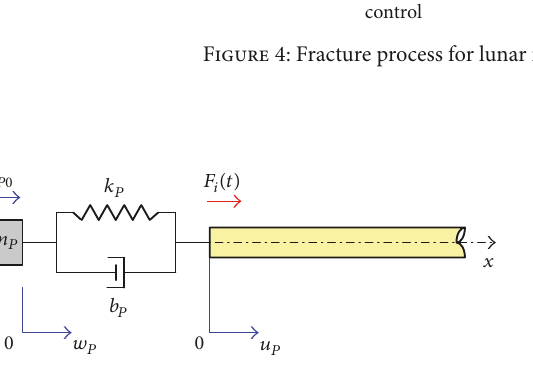
Figure 5: Simplified mechanical model of the collision between the hammer and the